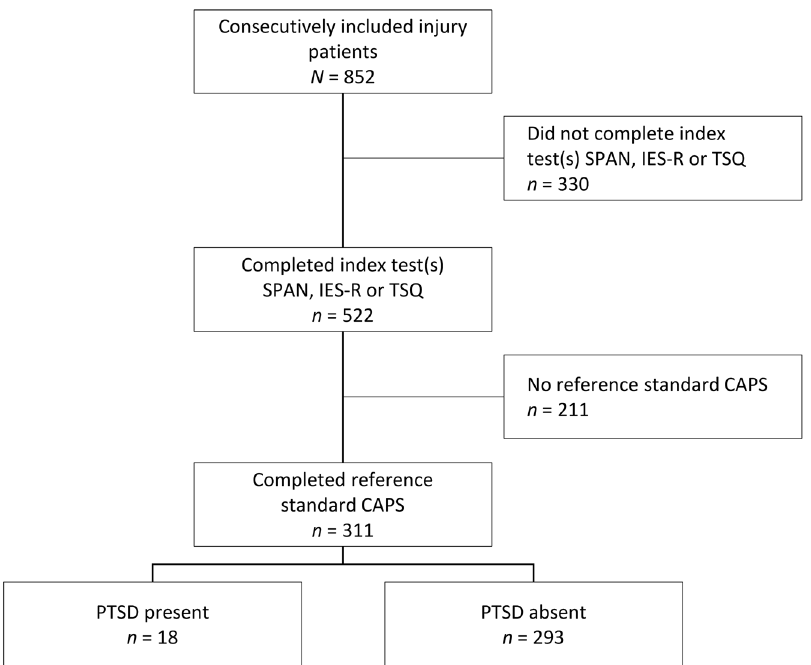
Figure 1. Flow chart of participants for screening for 6 month PTSD.